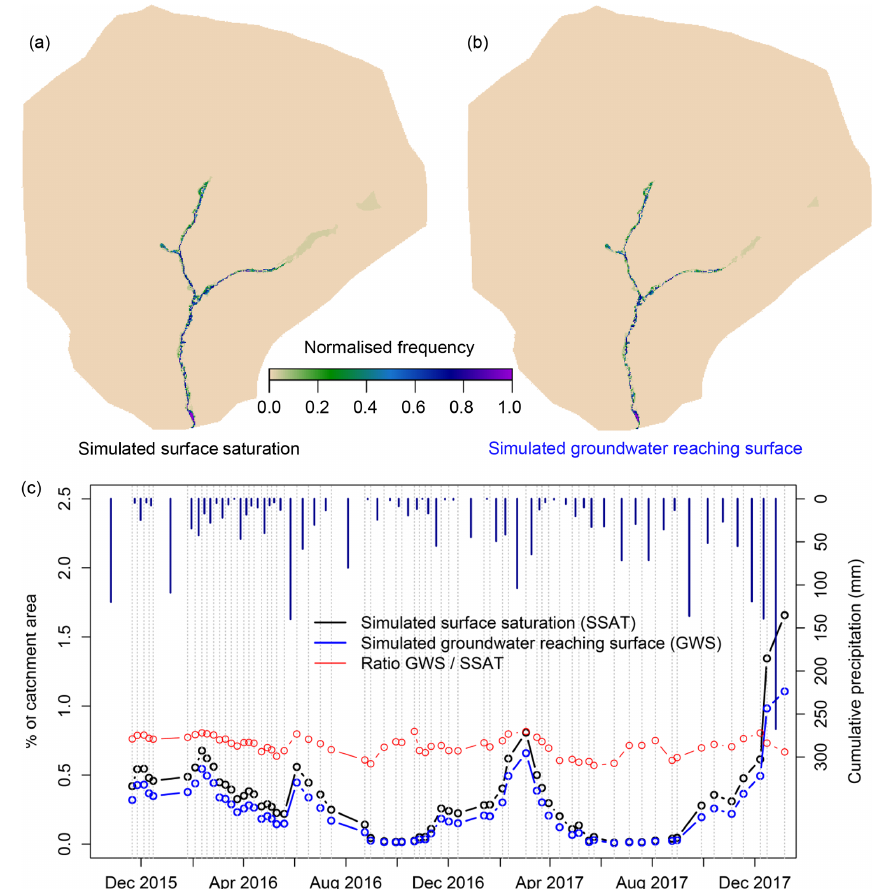
Figure 4. Frequency maps (a, b) and time series of areal percentage (c) of simulated surface saturation and simulated groundwater reaching the surface in the Weierbach catchment. Surface saturation ( a , black line in c ) corresponds to a simulated water depth>10 − 4 m in the surface domain of the model. Groundwater reaching the surface ( b , blue line in c ) corresponds to a complete saturation of the subsurface domain of the model, independent of the wetness state of the surface domain. Precipitation is given as cumulative amounts between the observation dates (grey dashed